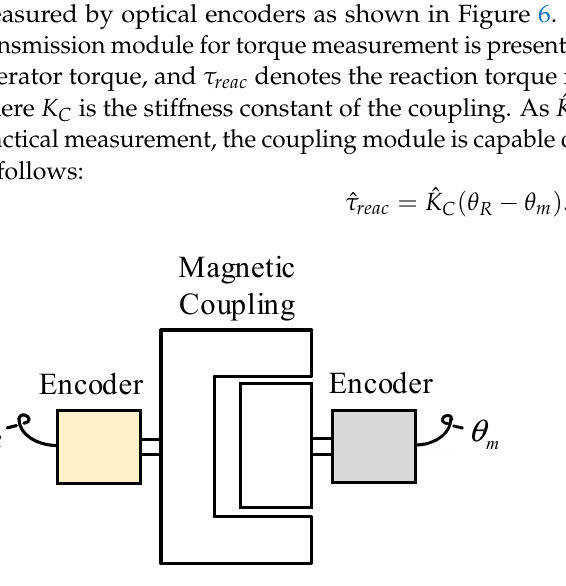
Figure 6. Schematic graph of magnetic coupling transmission module.